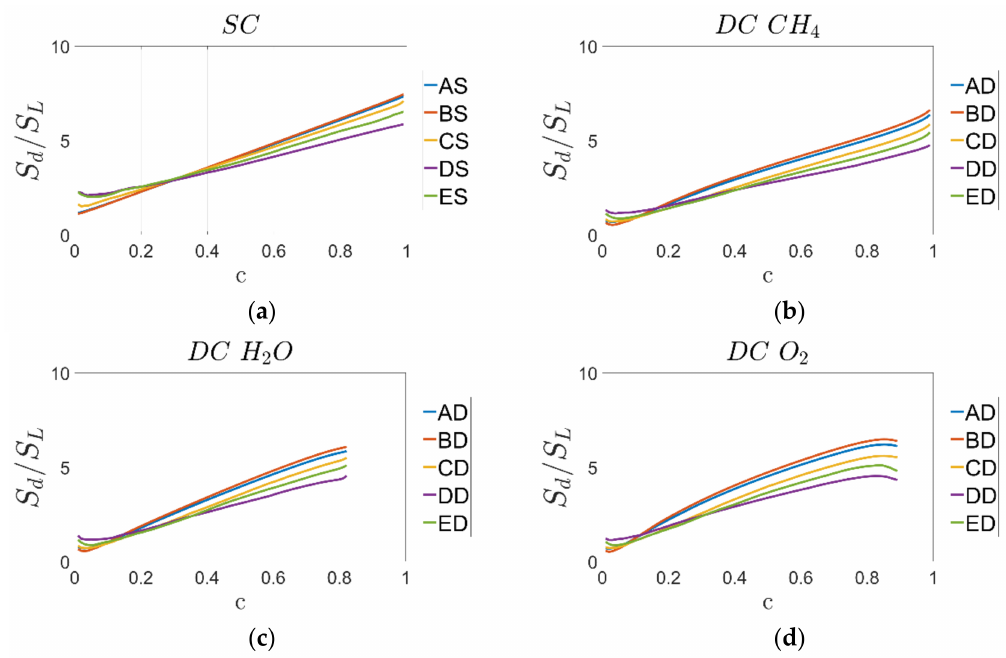
Figure 5. Mean variation of normalised displacement speed S d / S L across the flame for cases A–E for ( a ) SC and ( b – d ) DC simulations for reaction progress variable based on CH 4 , H 2 O,O 2 mass